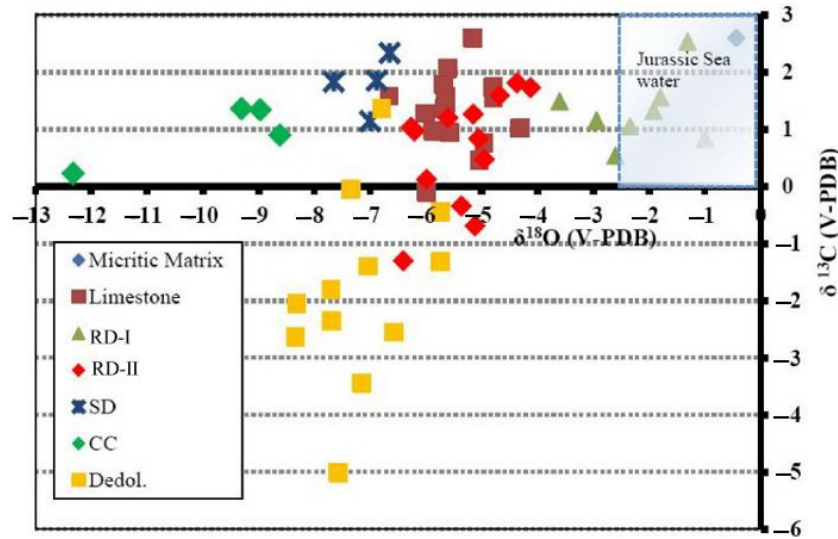
Figure 7. Cross-plot between carbon and oxygen isotopes. The blue box indicates the Jurassic marine seawater signatures of NW Tethys, compiled after Al-Mojel, Dera, Razin, and Le Nindre [50]. RD-I: matrix dolomite, RDII, replacive dolomite, SD: saddle dolomite, CC: fracture-filling calcite cement, Dedol: dedolomite. The unaltered micrite matrix shows a δ 18 O value of − 0.44‰ V-PDB ( n = 1) and a δ 13 C value of − 2.6‰ V-PDB ( n = 1). The δ 18 O values of host limestone range from − 6.66‰ to − 4.31‰ V-PDB ( n = 15), and δ 13 C values range from − 0.11‰ to 2.07‰ V-PDB ( n = 15). The values show the depletion trend in oxygen isotope values when compared with the signature of the Jurassic marine carbonates, while the carbon isotopic values are consistent (RD-I) range from − 2.94‰ to − 0.99‰ V-PDB ( n = 8), and the δ 13 C ranges from 0.53‰ to 3.19‰